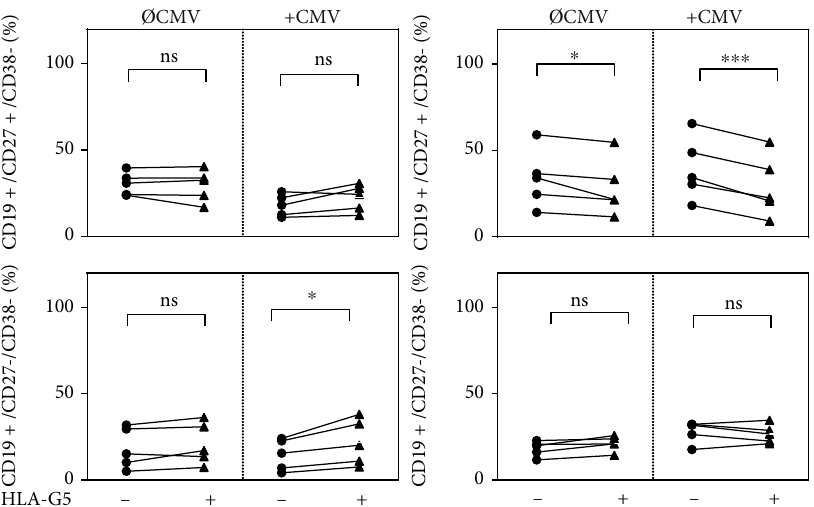
Figure 4: Human leukocyte antigen G5 (HLA-G5) signi fi cantly decreases the proportion of CD27 + CD38 + in the total population of splenic B cells and increases the proportion of CD27 - CD38 - B cells. CD27 and CD38 were analyzed by fl ow cytometry. . Statistical signi fi cance ( P < 0 : 05 ) was determined by two-tailed t- test. ns: not signi fi cant; ∗ P < 0 : 05 ; ∗∗∗ P < 0 : 001